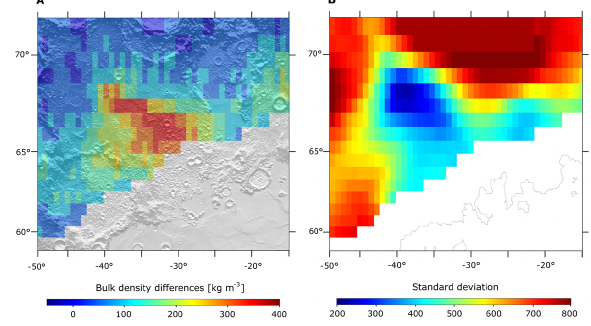
Figure 8. Region of large inconsistence of the two tested methods at the northern rim of PKT. (A) Bulk density difference (bulk density from correlation between topography and Bouguer anomalies minus bulk density from Bouguer roughness) with shaded topography in the background (B) Surface roughness, given as the standard deviation of the